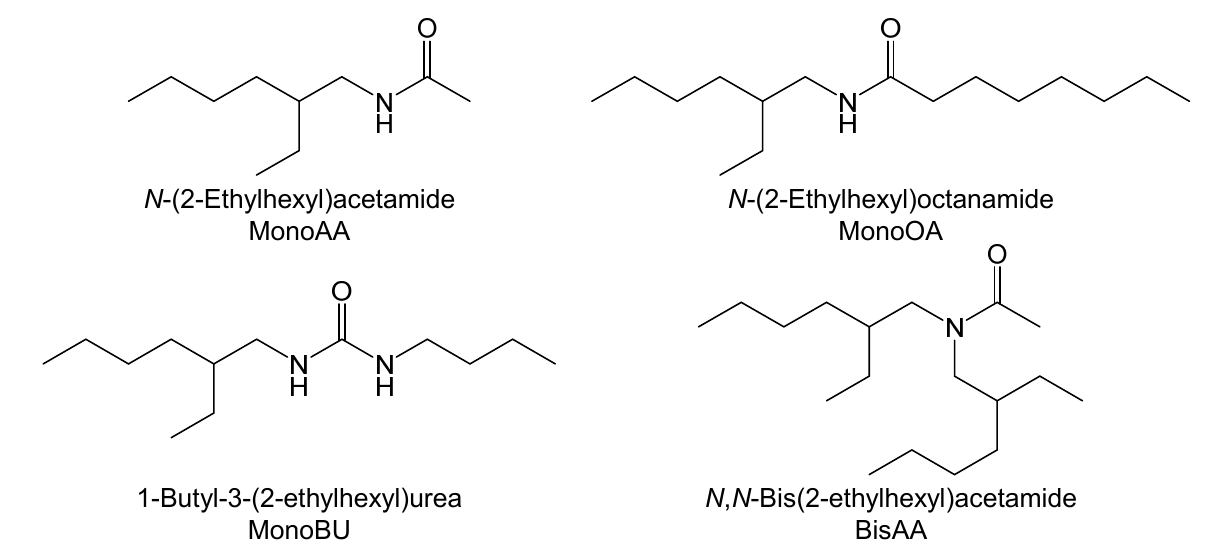
Figure 1. Representation of the chemical structures and abbreviations of the extractants.